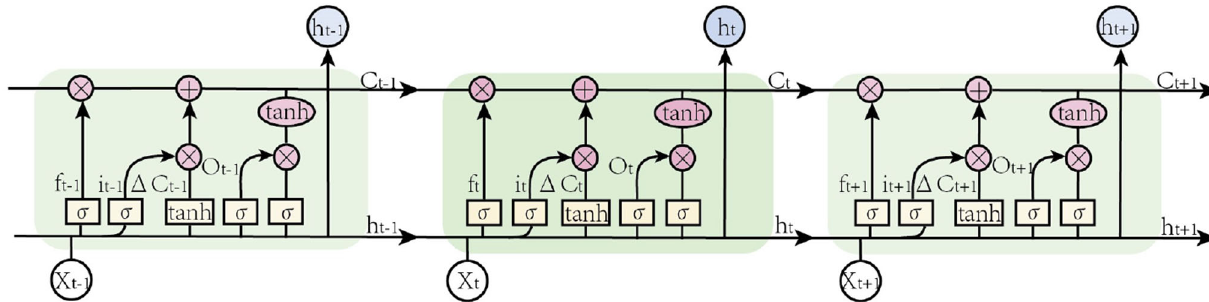
Fig. 1 LSTM structure